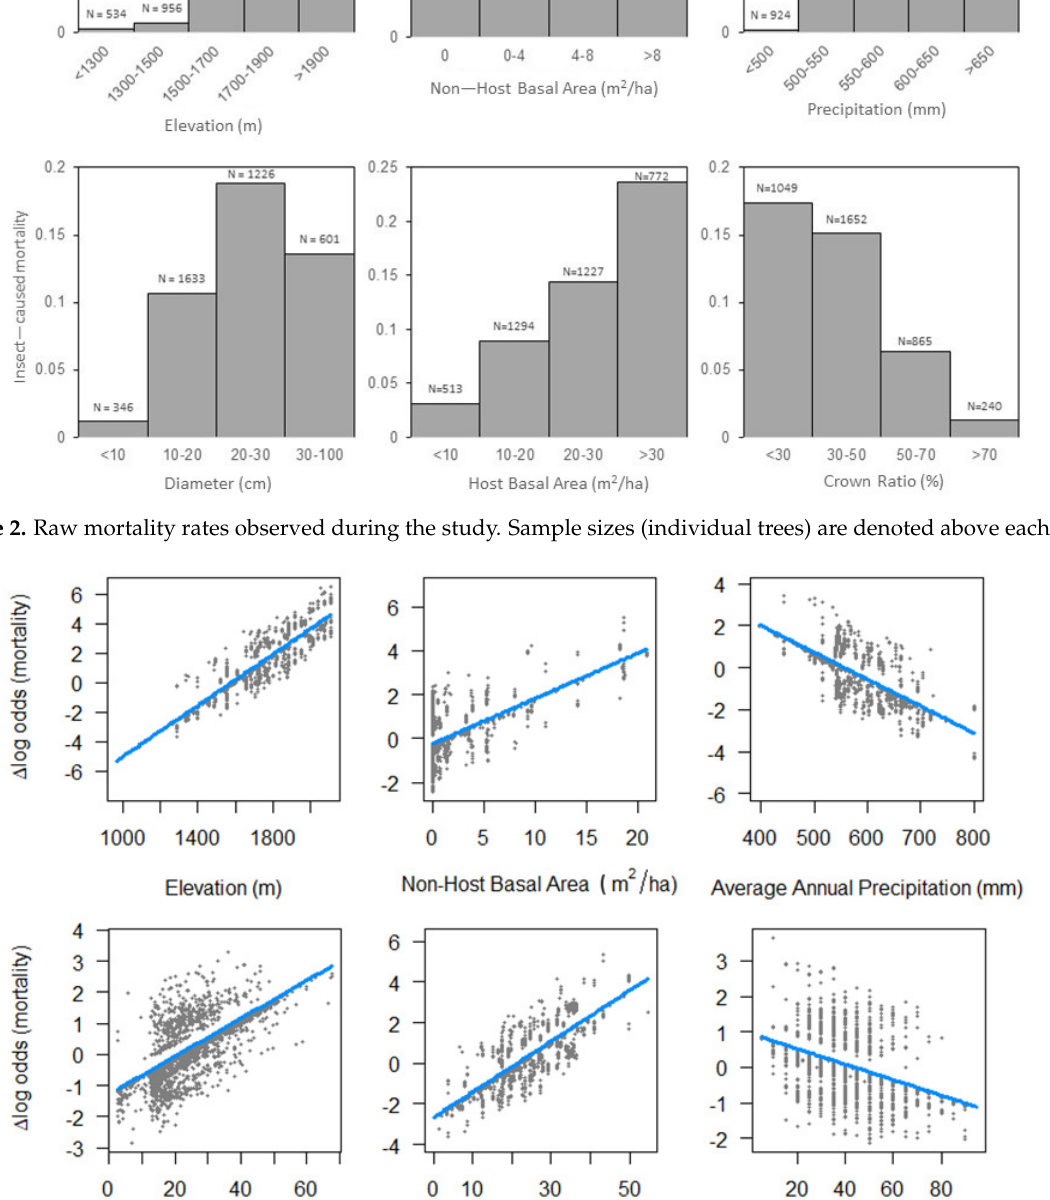
Figure 3. Several tree, stand, and climatic variables were correlated with mortality risk. This figure is derived from the additive model in Objective 2 containing all significant tree, stand, and climate variables. Mortality risk is depicted on the y -axis as the change in log odds of insect-caused mortality (relative to the average value of the dependent variable), con- trolling for the other variables in the model.